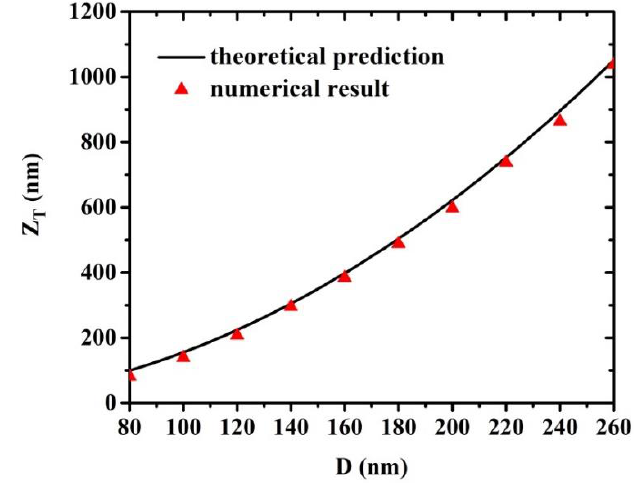
Figure 3. The Talbot distance Z T as a function of period D, where the input wavelength is 7 µ m and chemical potential is 0.3 eV.